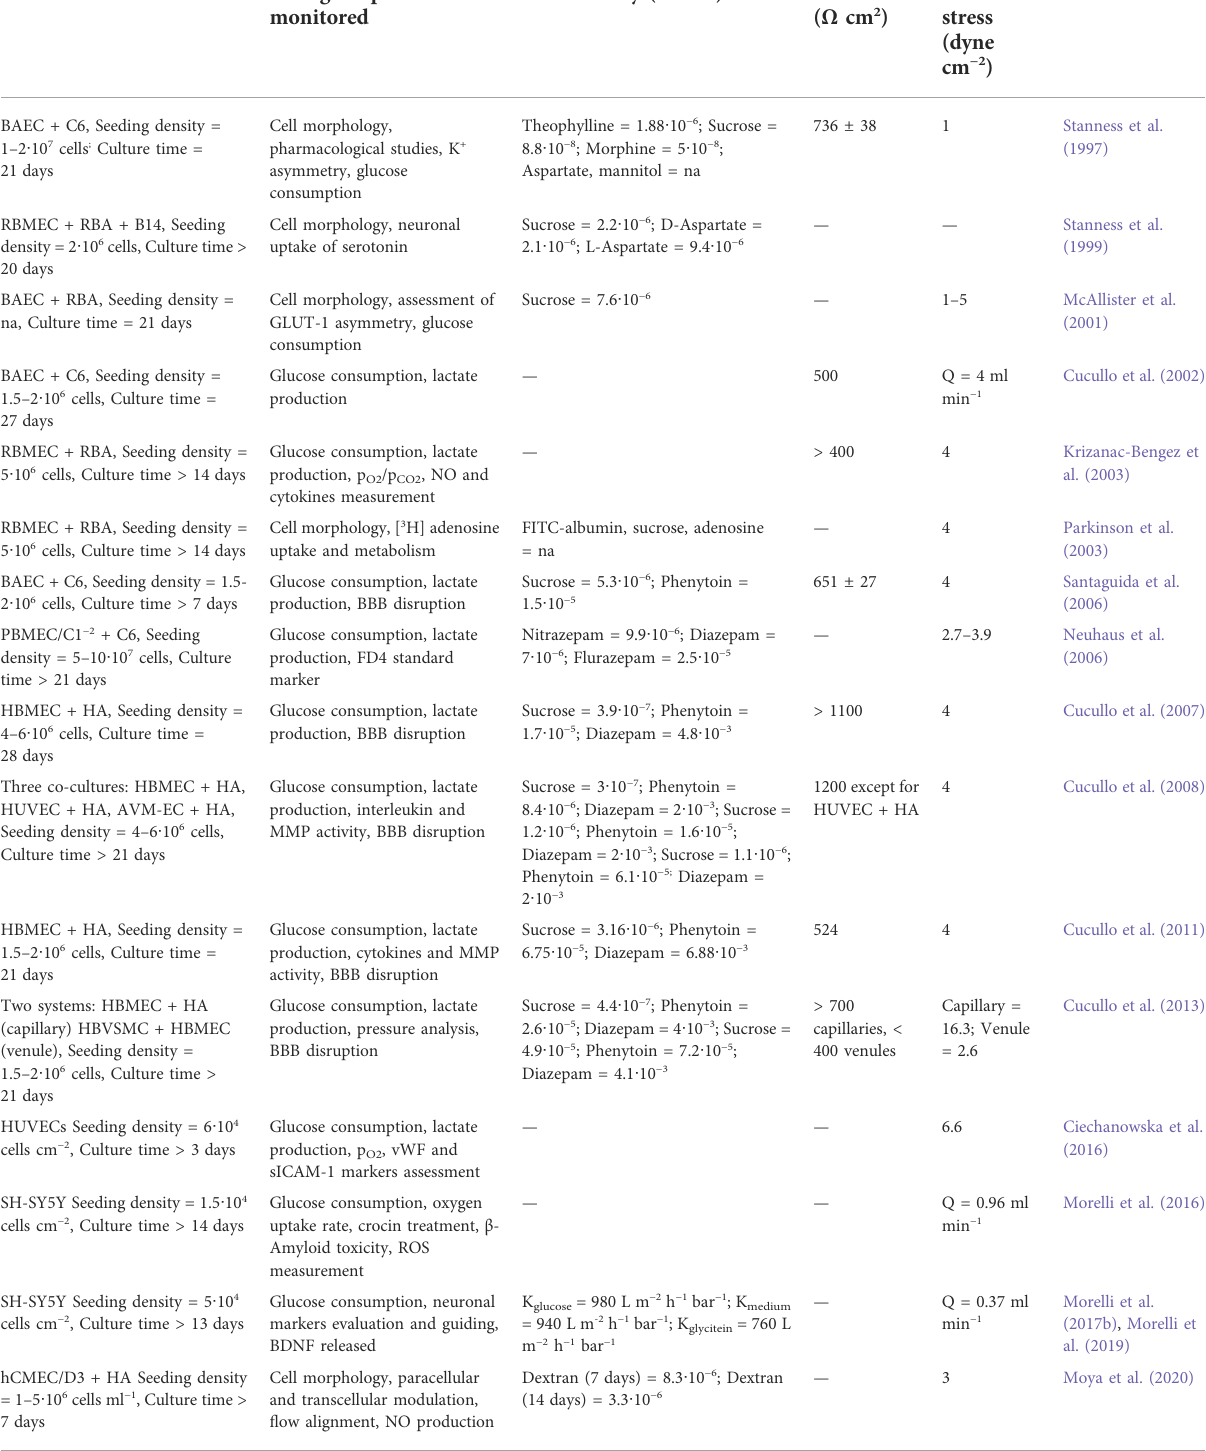
AVM-EC, arteriovenous malformations endothelial cells; BDNF, brain-derived neurotrophic factor; B14, immortalized rat neuronal cell line; FD4, FITC-dextran 4000; HA, human astrocytes; HBVSMC, human brain vascular smooth muscle cells; HUVECs, human umbilical vein endothelial cells; K medium , culture medium permeance; K glucose , glucose permeance; K glycitein ,glyciteinpermeance;MMP,matrixmetalloproteinase;na,notavailable;NO,nitricoxide;PBMEC/C1-2,porcinebrainmicrovascularendothelialcellline;p CO2 ,partialpressureof carbon dioxide; p O2 , partial pressure of oxygen; Q, fl owrate; RBA, rat brain astrocytes; RBMEC, rat brain microvascular endothelial cells; ROS, reactive oxygen species; SH-SY5Y, human neuroblastoma